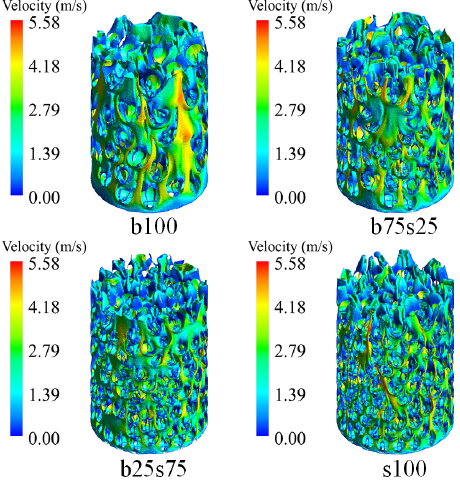
Figure 13. The 3D velocity distributions in different packing structures.